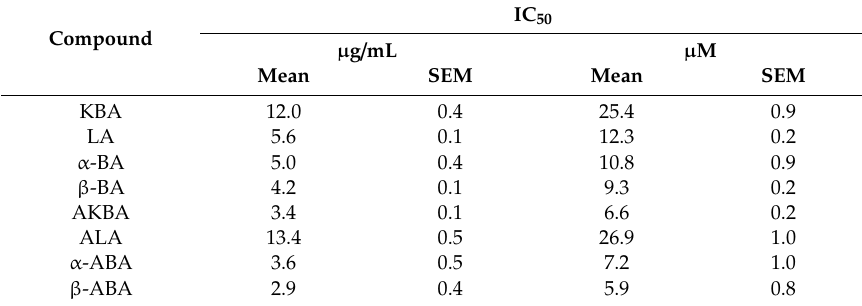
Table 5. Cytotoxic e ffi cacies of the individual pure BAs and LAs against MDA-MB-231. Compound